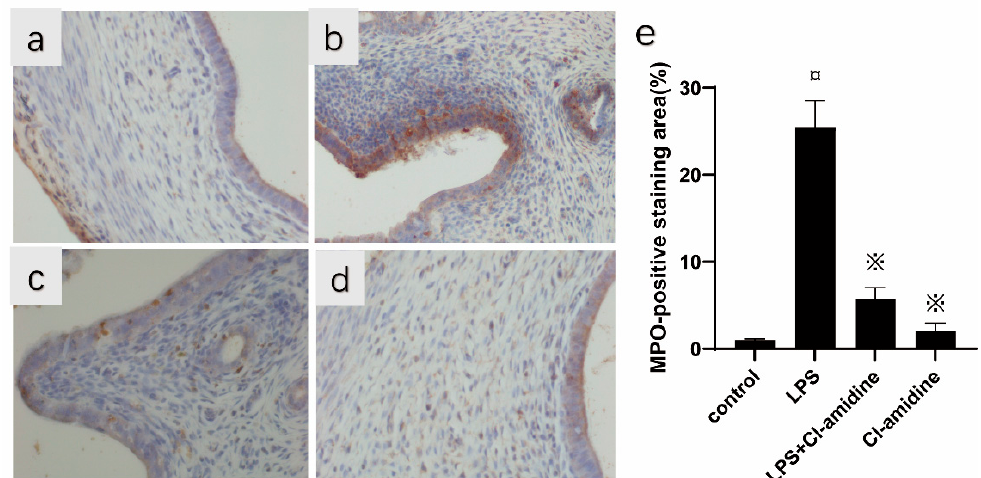
Figure 4. Immunohistochemical staining results of uterus tissue. Representative images of Myeloperoxidase expressing neutrophil infiltration by immunohistochemical staining in ( a ) control group, ( b ) LPS group, ( c ) LPS + Cl-amidine group, and ( d ) Cl-amidine group. ( e ) Percentage area of positive MPO staining for the above four groups. Data were represented by mean ± SD ( n = 5 animals per group). ¤ p < 0.05 vs. control rats and ※ p < 0.05 vs. LPS without Cl-amidine. The dark yellow color indicates positive MPO, indicating the presence of neutrophils, and the light blue color is the nucleus.